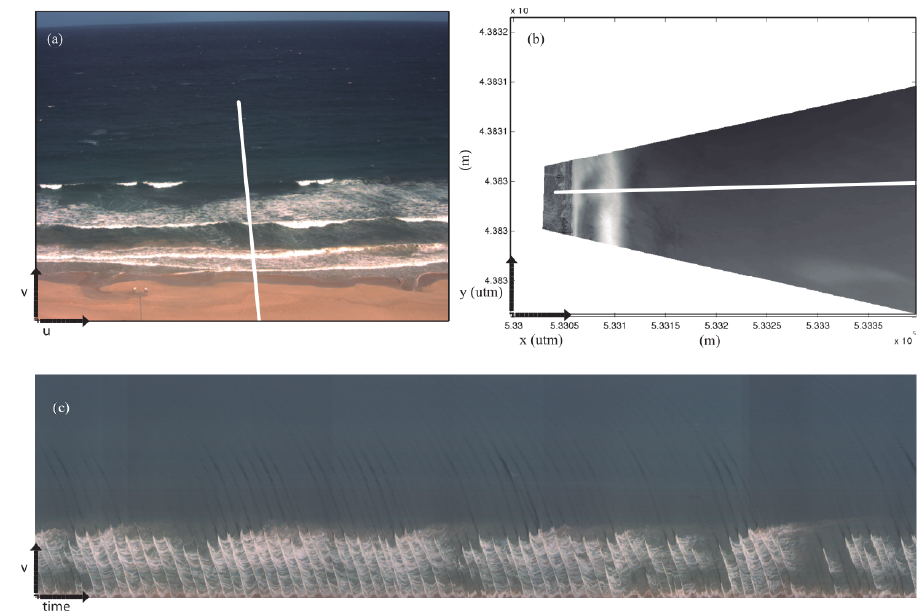
Figure 6. (a) Cross-shore transect defined for the time stack image on camera no. 3. The figure shows the original image in the ( u,v ) ≡ pixel coordinate system. (b) The same after rectification in the ( x,y ) ≡ UTM coordinate system. (c) Resulting time stack for 19 March at 10:00UTC +